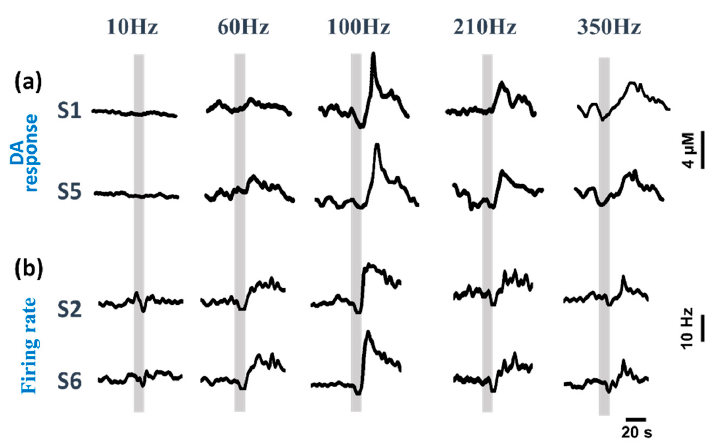
Figure 4. Dual ‐ mode signals variations during different frequencies applied. ( a ) The variation of DA concentration, and ( b ) neural spike firing rate after subthalamic nucleus (STN) ‐ DBS with different stimulation frequencies. The gray box means the duration of the stimulation.